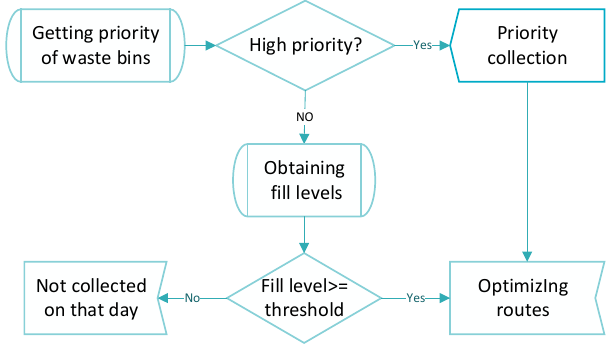
Figure 6. Flowchart of priority and knowledge-based decision making.